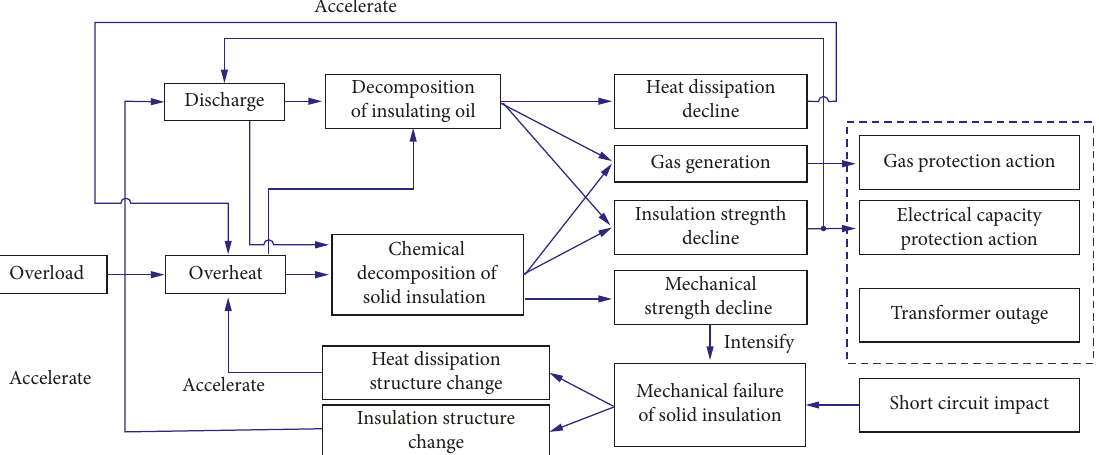
Figure 4: Mechanism of transformer’s internal faults